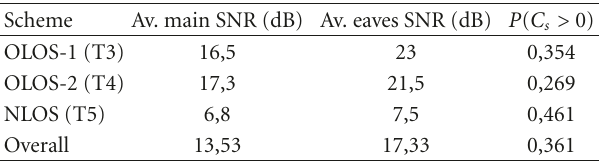
Table 7: Average SNR and P ( C s > 0) values for each scheme and overall.